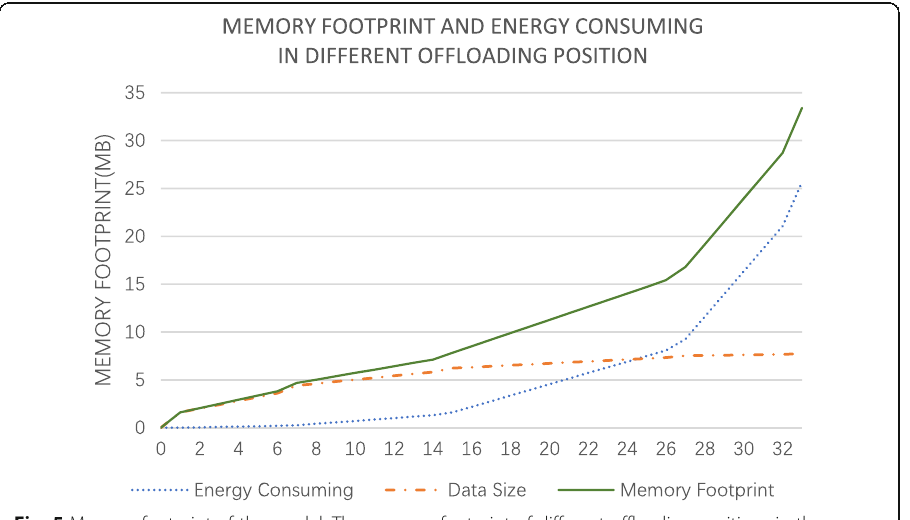
Fig. 5 Memory footprint of the model. The memory footprint of different offloading positions in the ResNET-34